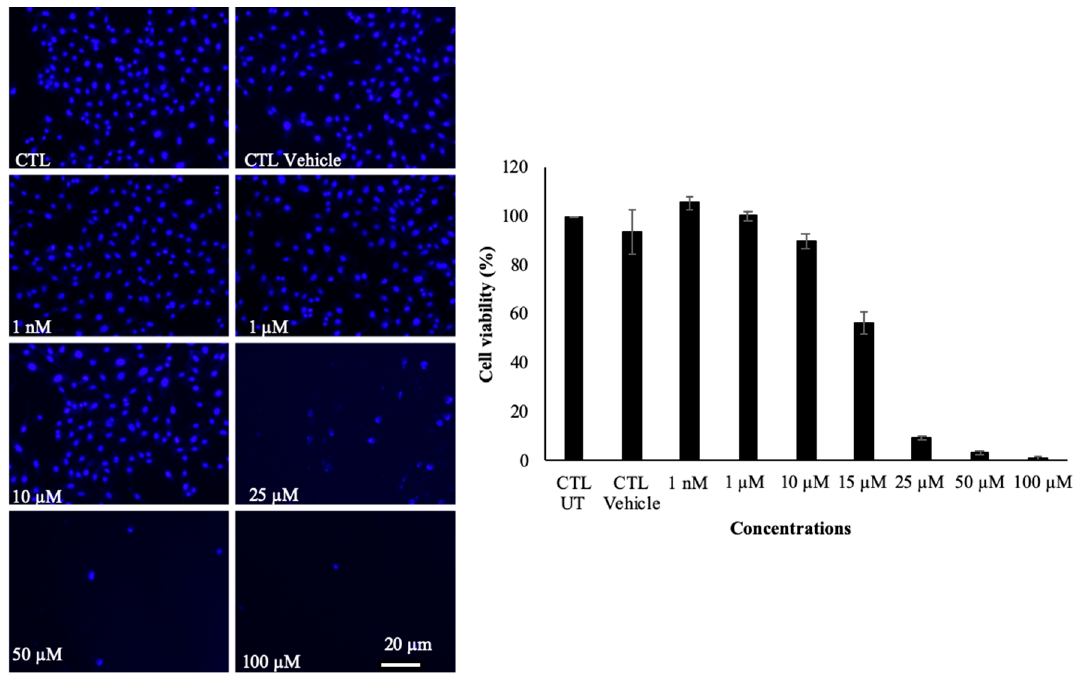
Figure 4. Glioblastoma cell viability studies: U251N cells were treated with aqueous formulations of the telodendrimer (1 nM, 1 µM, 10 µM, 25 µM, 50 µM and 100 µM) for up to 72 h. Cells were fixed and stained with Hoechst 33342. Vehicle indicates 15% milli-q water. More than 130 images were analyzed for each condition. Number of cells were quantified by imaging them using Leica Fluorescent Microscope.